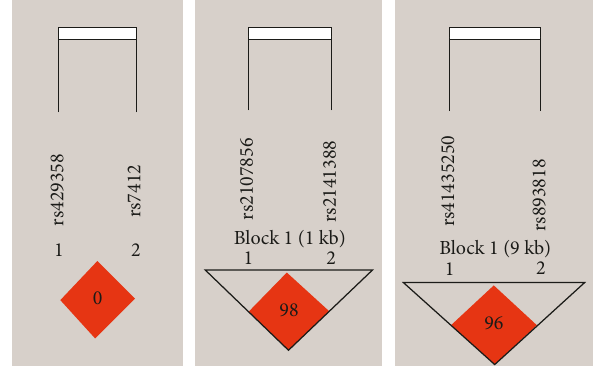
Figure 1: The genotyping graphs for LOXL1, APOE, and